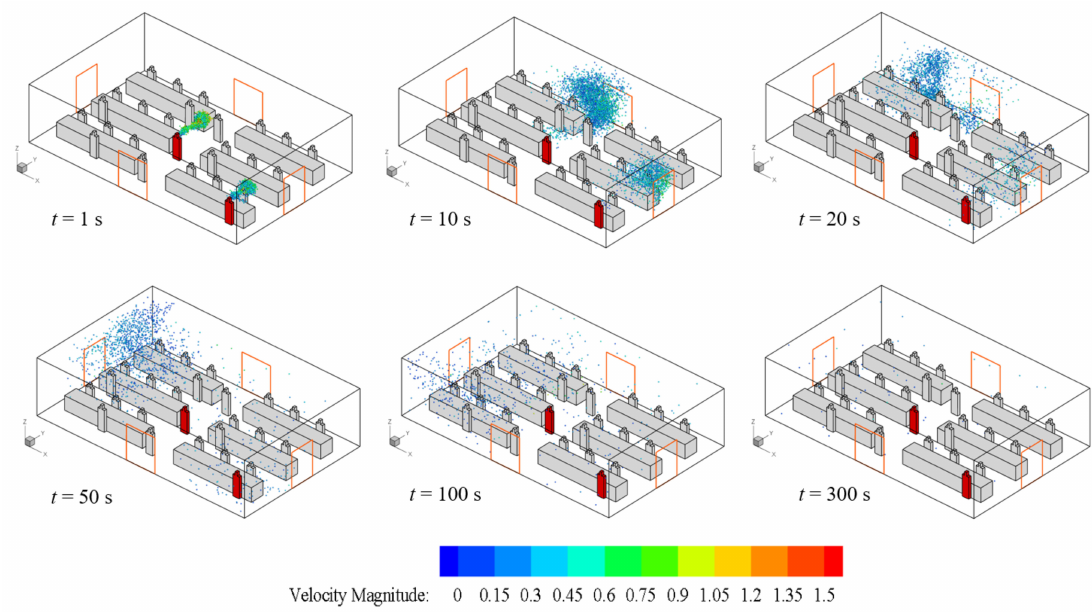
Figure 8. Distribution of aerosols in case 4 (front, back, left, and right doors are